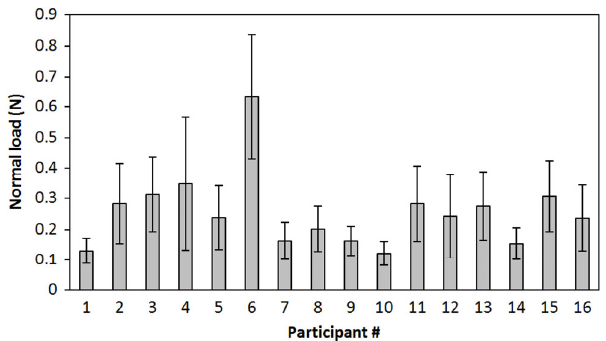
Fig. 4 The average applied normal load (with standard deviation) of each participant during friction measurements.